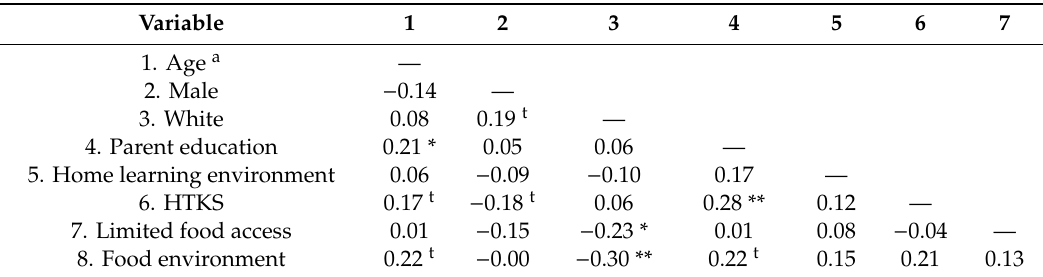
Table 2. Correlation matrix for all study variables (N = 102).